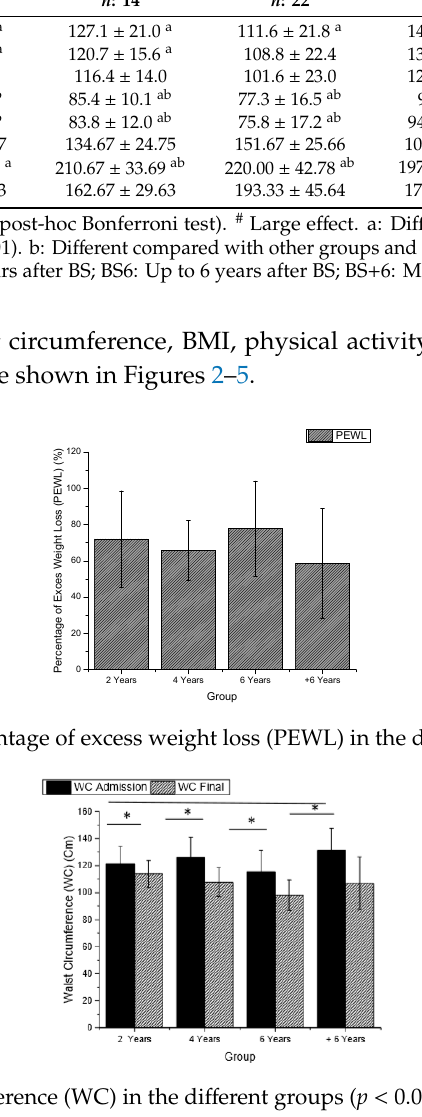
Figure 5. Quality of life in different groups ( p = 0.049, f 2 of Cohen = 0.099). Changes in biochemical marker levels are shown in Table 4. LDL and total cholesterol levels significantly improved postoperatively in BS2, BS4, and BS+6. Triglyceride levels improved significantly in all groups and glycemia levels significantly improved in BS +6.